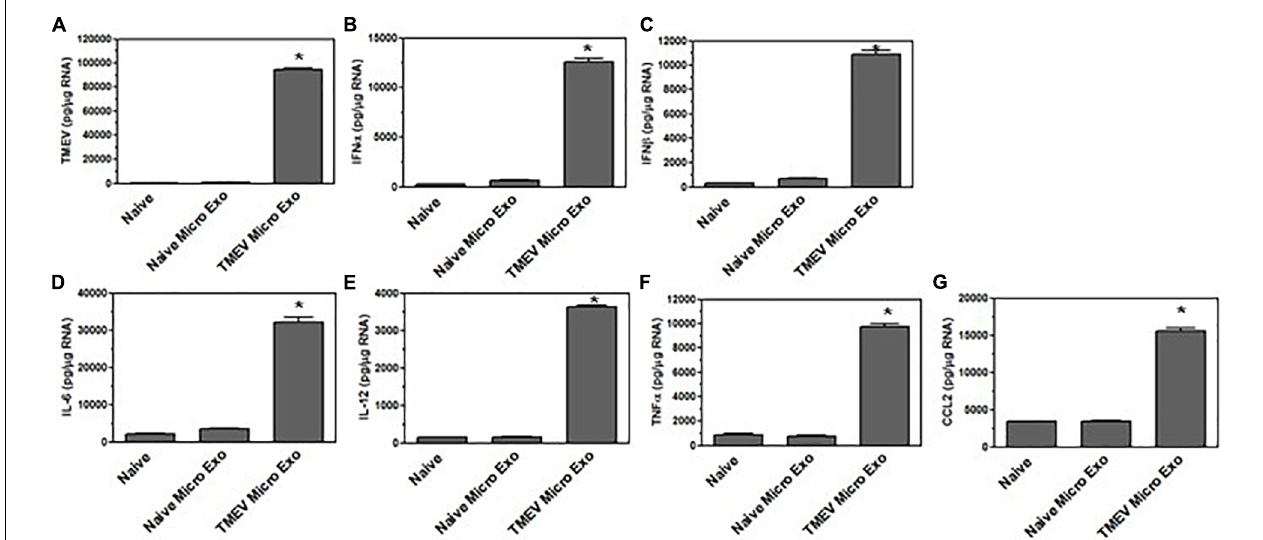
FIGURE 4 | Exosomes from TMEV-infected microglia activate bystander astrocytes. Exosomes were isolated from uninfected (naïve) microglia or TMEV-infected microglia and placed on naive astrocytes for 24 h. Astrocytes were lysed, RNA isolated, converted to cDNA, and analyzed by real time PCR for expression of TMEV